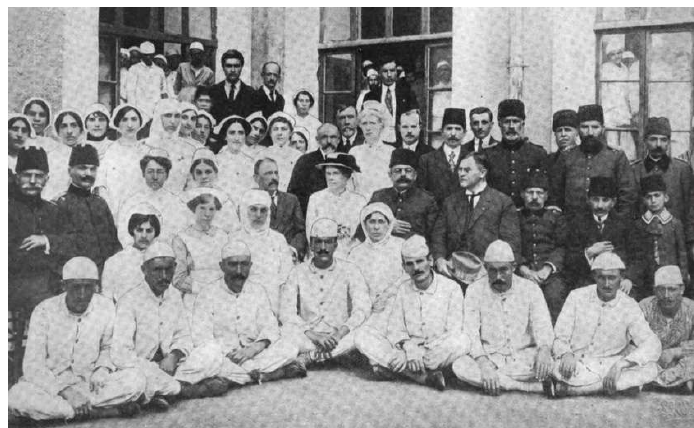
Figure 3. Photograph of Red Cross hospital workers in Constantinople (1915 or 1916). The American Red Cross and mission boards collaborated during World War I. While the Red Cross had far more funds and political access than the American Board or BFM, it paled in comparison to the mission boards’ on-the-ground overseas resources in the Ottoman Empire. Source: Missionary Herald 112, no. 3 (March 1916):